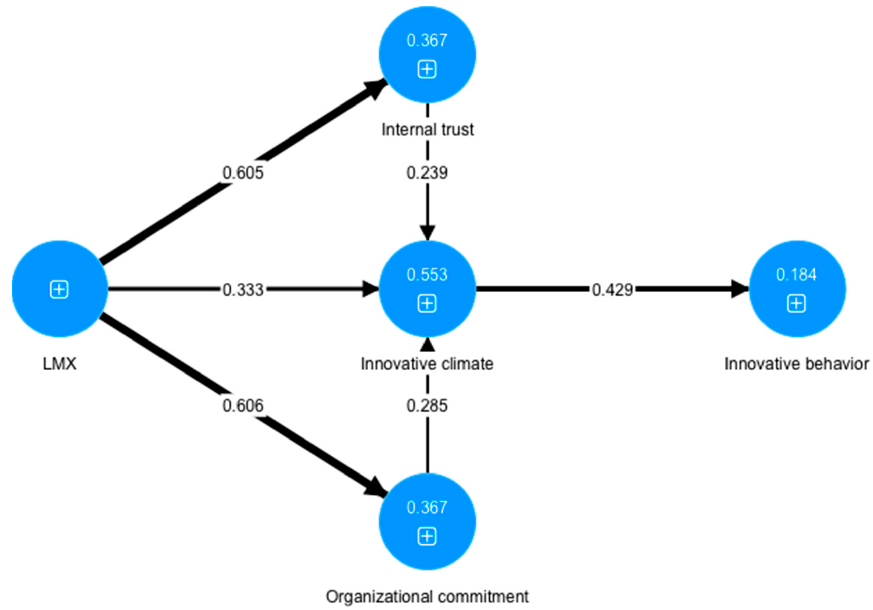
Figure 2. The structural